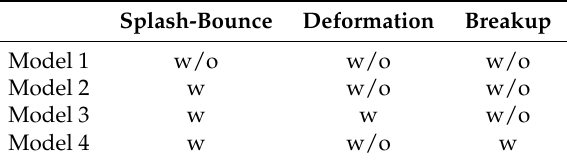
Table 2. Computational cases for NACA0012 icing